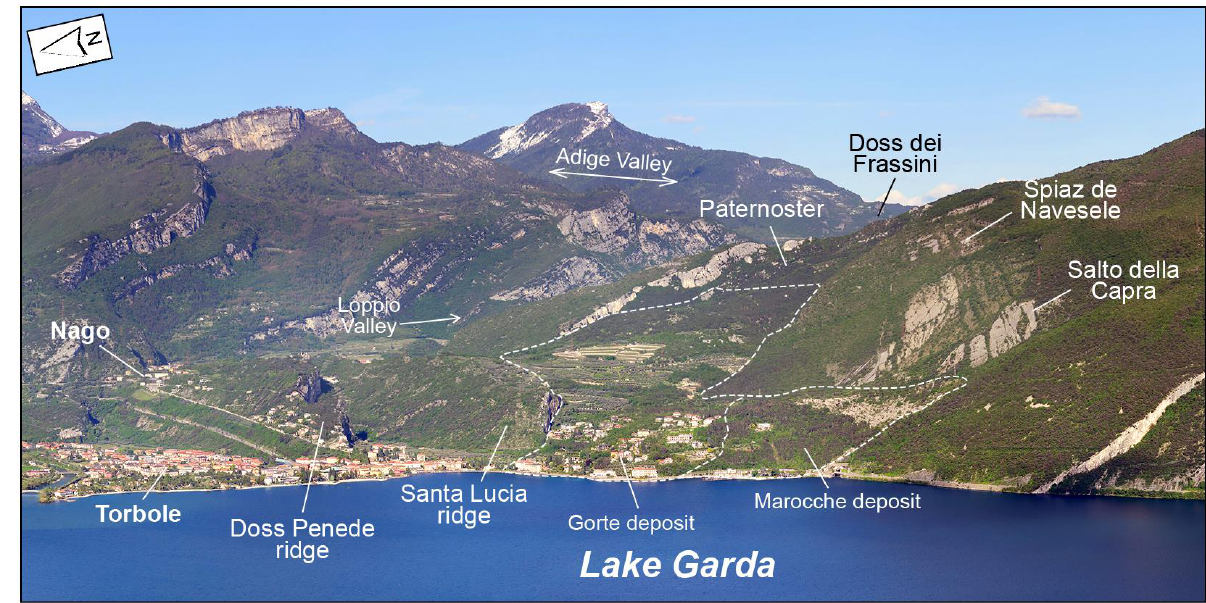
Figure 3. Overview of the landslides of Gorte (on the left) and Marocche (on the right). The latter is due to the visible sliding planes of the Spiaz de Navesele and Salto della Capra. Mouth of the Sarca River seen on the far left of the image. Photo taken from the western side of Lake Garda (photo courtesy of Dr. Matteo Visintainer).